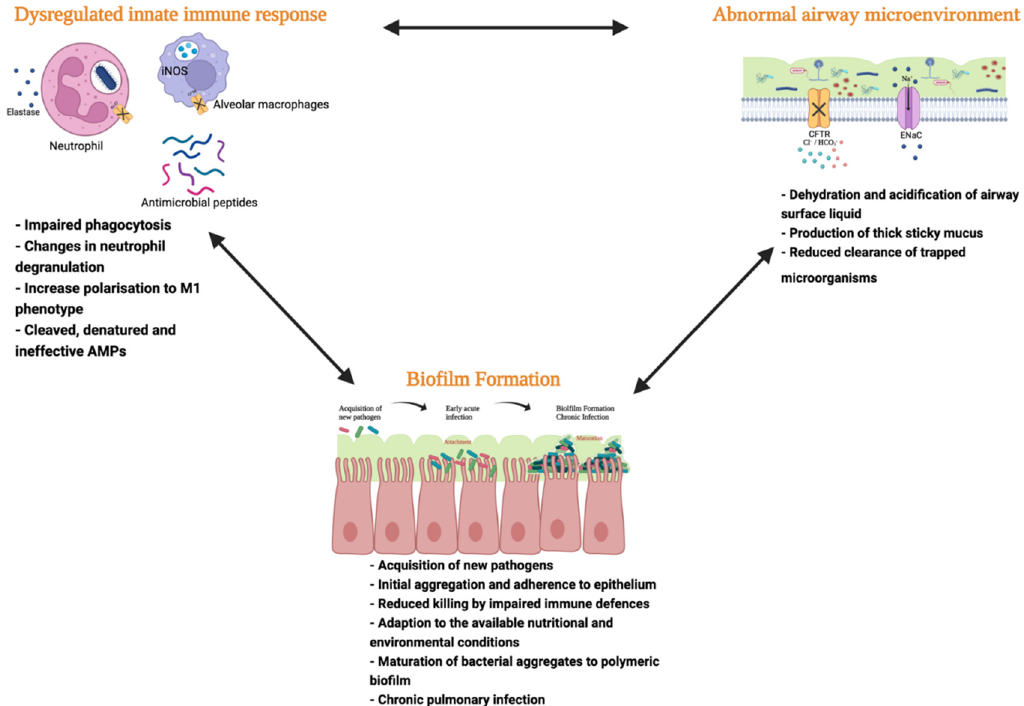
Figure 1. Factors contributing to an increased risk of airway infection in Cystic fibrosis (CF). Aberrant airway microenvironment driven by defective cystic fibrosis transmembrane conductance regulator (CFTR) function results in dehydration and acidification of the airway surface liquid (ASL), impairing mucociliary clearance (MCC), and renders host innate defences ineffective. Acquisition of new microorganisms within the CF lung leads to the development of acute bacterial infections.